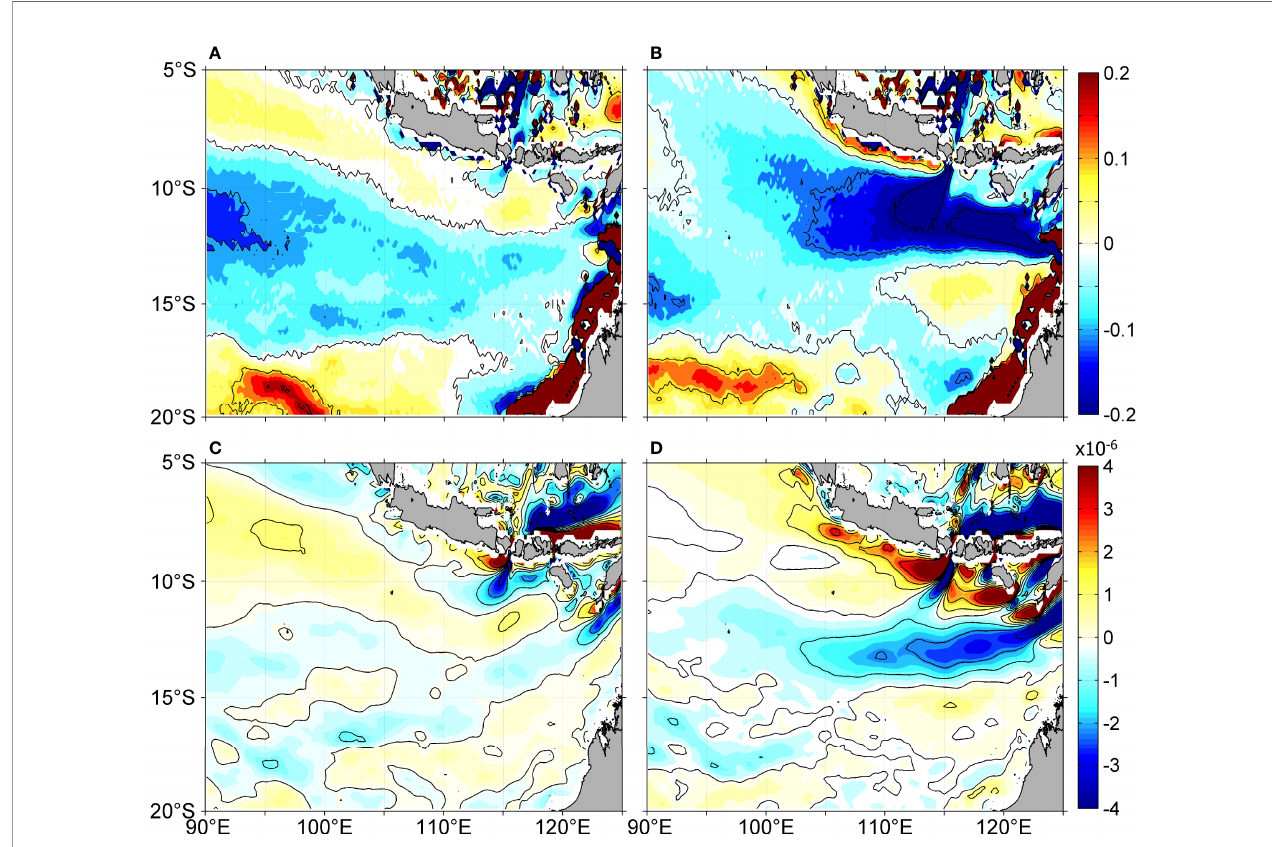
FIGURE 8 | Seasonal characteristics of dynamic environment in the background in austral summer (B, D) and austral winter (A, C) , respectively. (A, B) denote the meridional gradient of D25 (unit: m/km), in which the interval of contour lines is 0.1 m/km. (C, D) represent the meridional gradient of zonal current (unit: s − 1 ) averaged in upper 30 m, in which the contour lines denote the value of